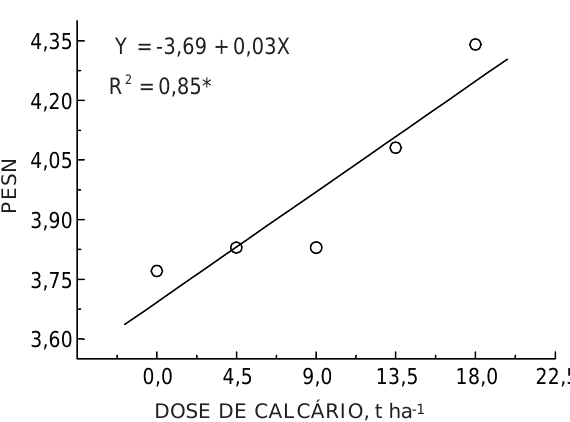
Figura 1. Relação entre as doses de calcário e o ponto de efeito salino nulo (PESN) do solo. * Significativo a